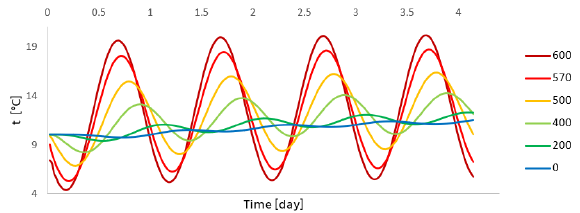
Figure 9. Temperature development in sensor spots, surface is represented by dark red line (600 ⇒ 600 mm from contact soil-concrete), contact with soil by blue line.